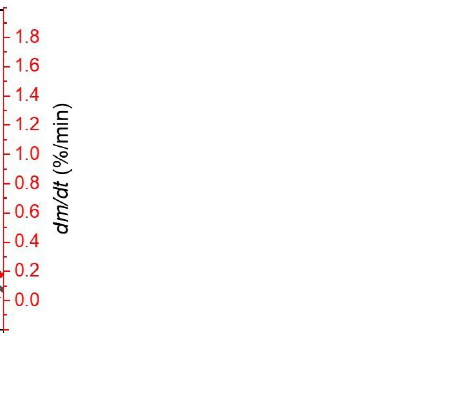
Figure 5. Weight loss and reactivity rate ( dm/dt ) curves of the iron ore-biomass pellet at a heating rate of 10 °C/min.